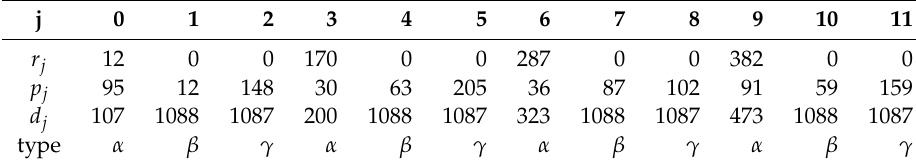
Table 10. Data of the instance E_1_12.